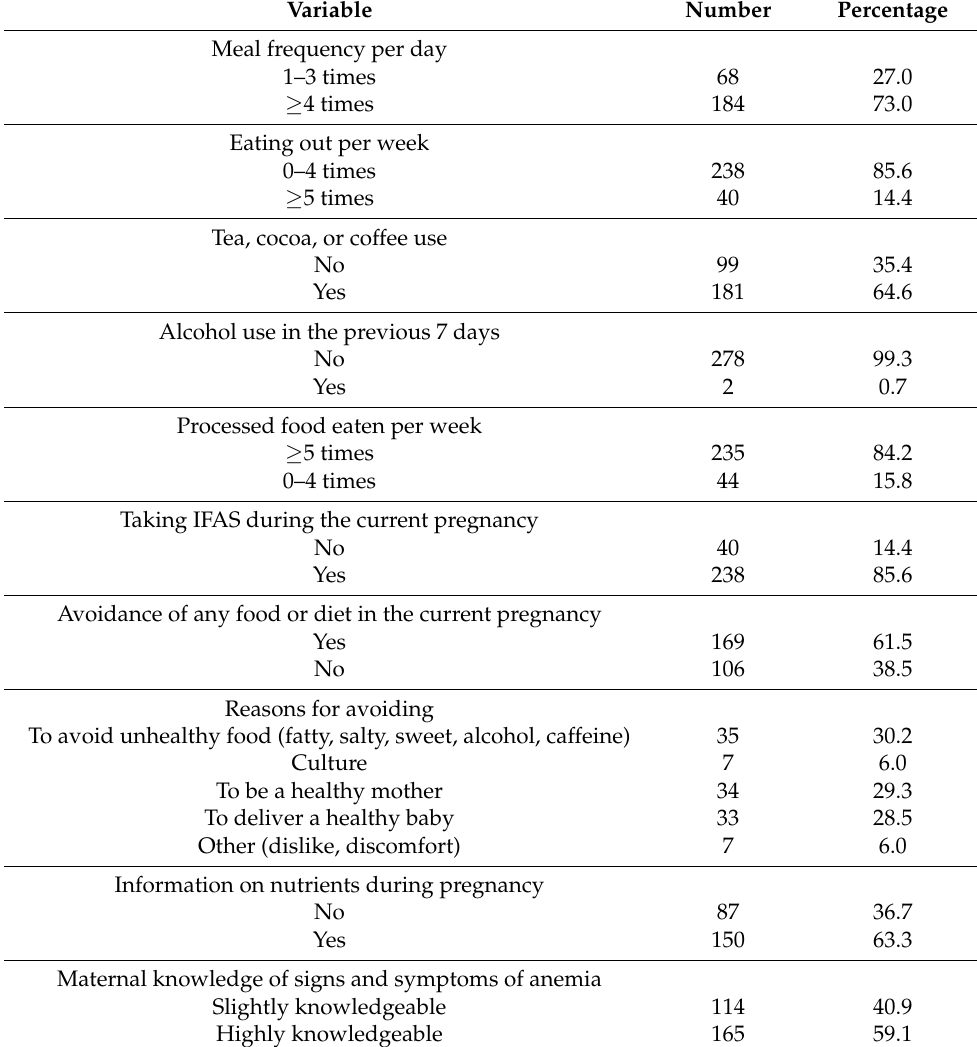
Table 2. Dietary practice and maternal knowledge on nutrients in pregnant women ( n = 280).